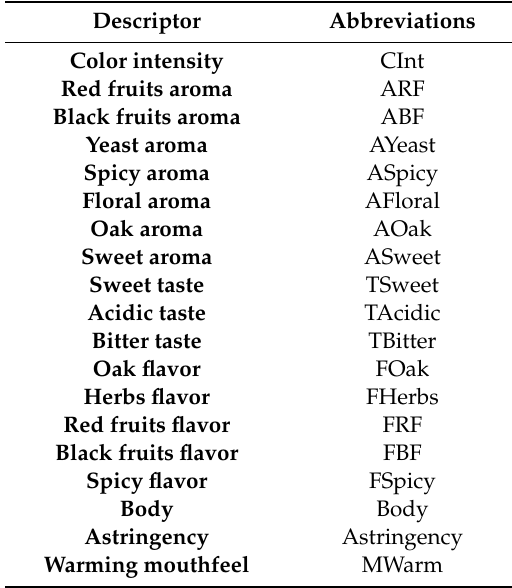
Table 1. Descriptors and abbreviations evaluated in the sensory